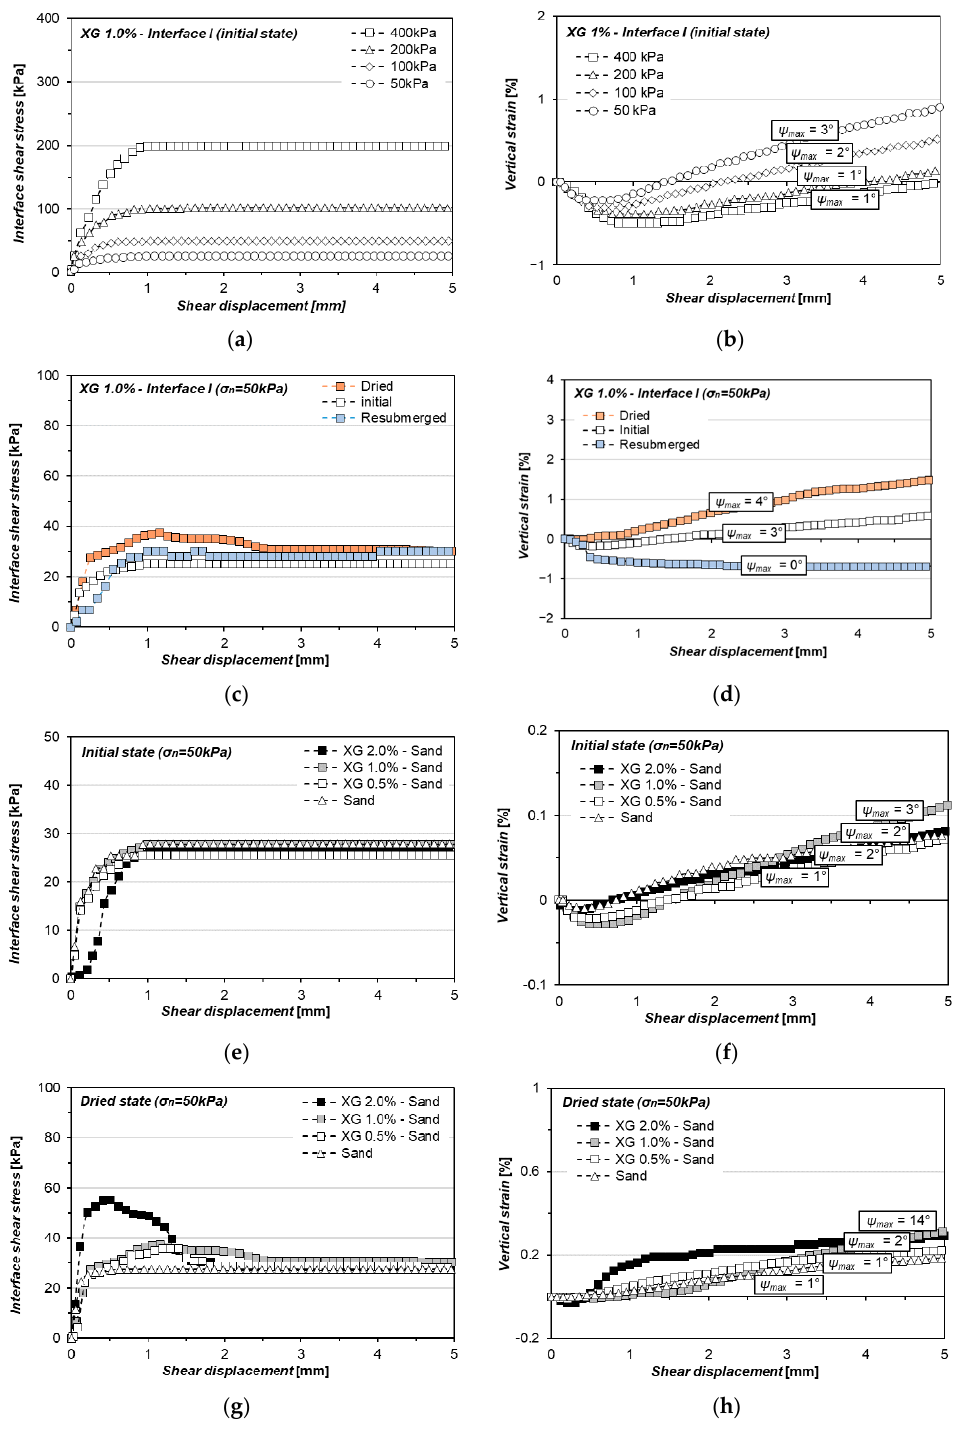
Figure 7. Interfacial shear test results of xanthan gum-treated soil without asperities ( Interface I ): ( a , c , e , g ) interface shear stress ( τ )-horizontal shear displacement ( δ ) curves; ( b , d , f , h ) vertical strain ( ε v )-horizontal shear displacement ( δ ) curves.